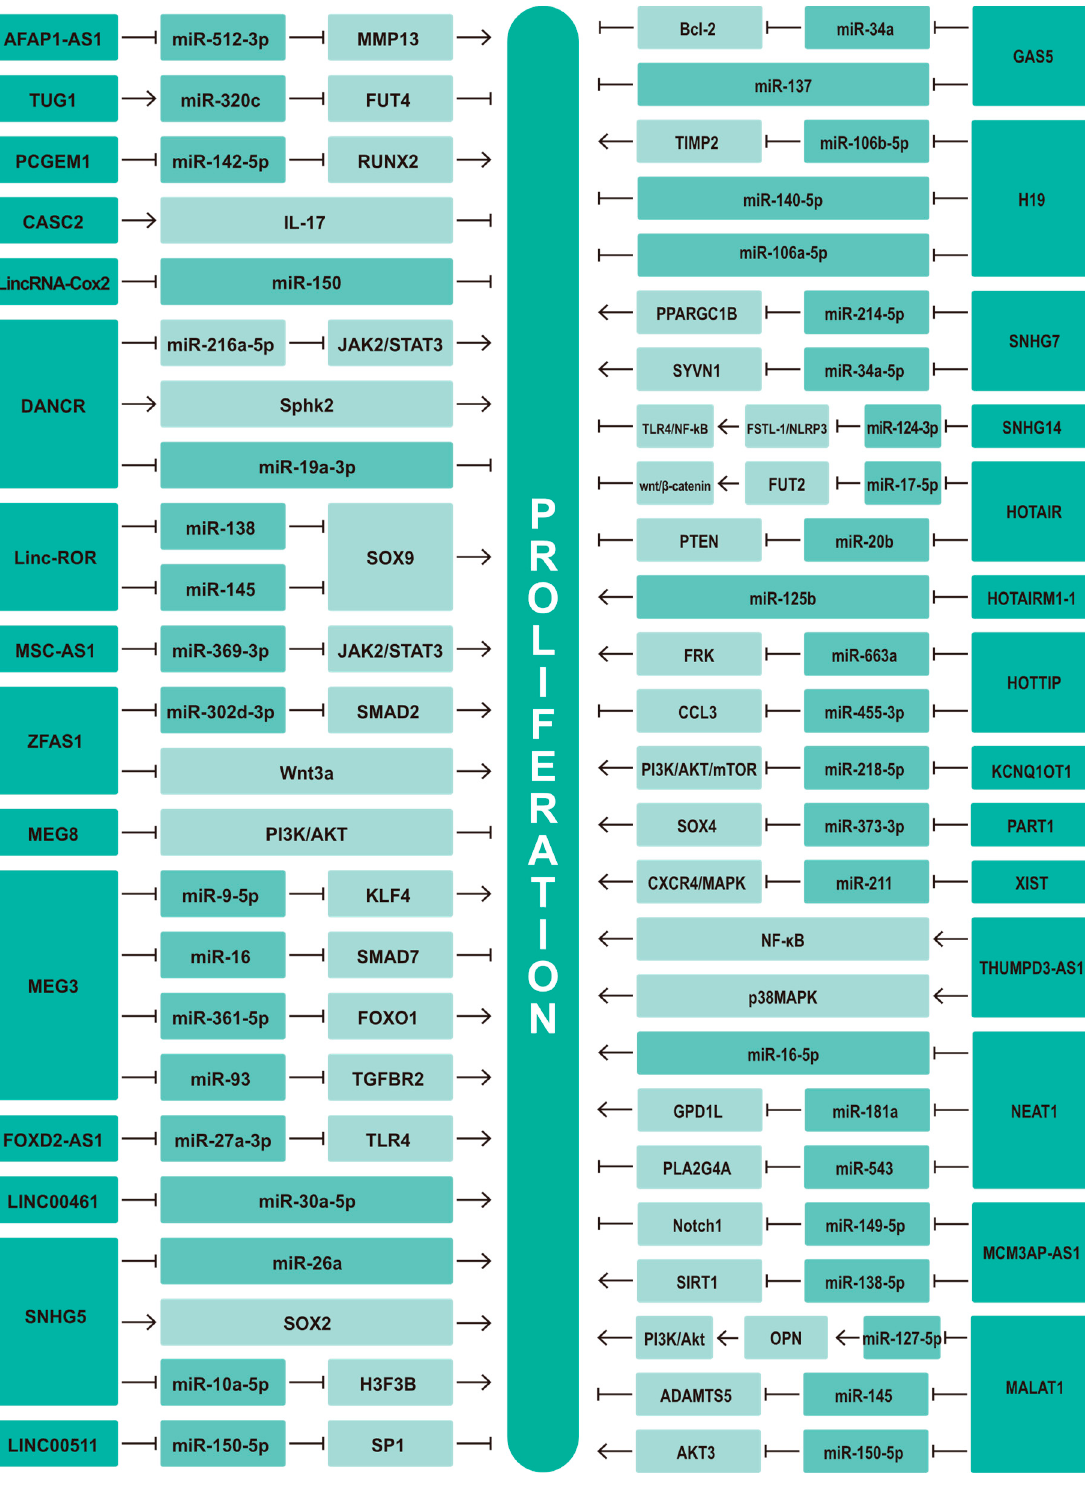
Figure 5. Schematic representation of the signaling pathways involved in this review for the regulation of cell proliferation by lncRNAs. Different shades of color represent different molecules.